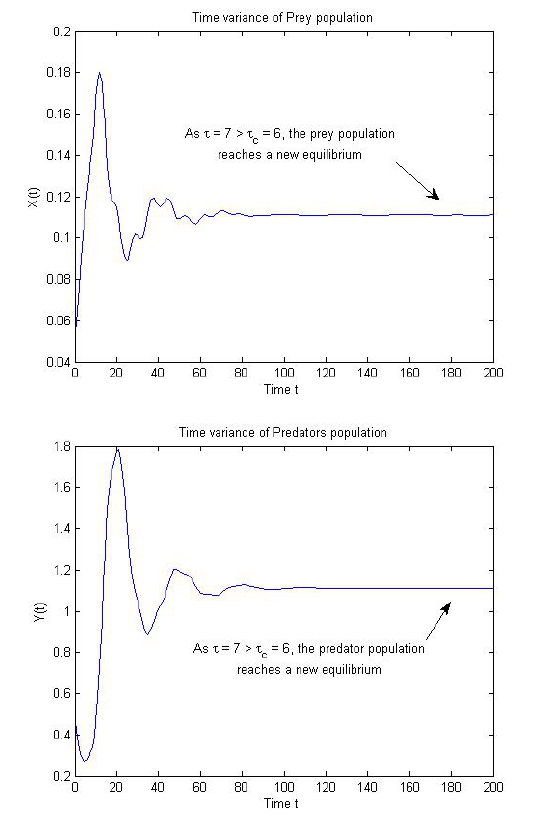
Fig. 6. The positive equilibrium is stable for τ 1 = 7 > τ 1 c = 6 and τ 2 = 0